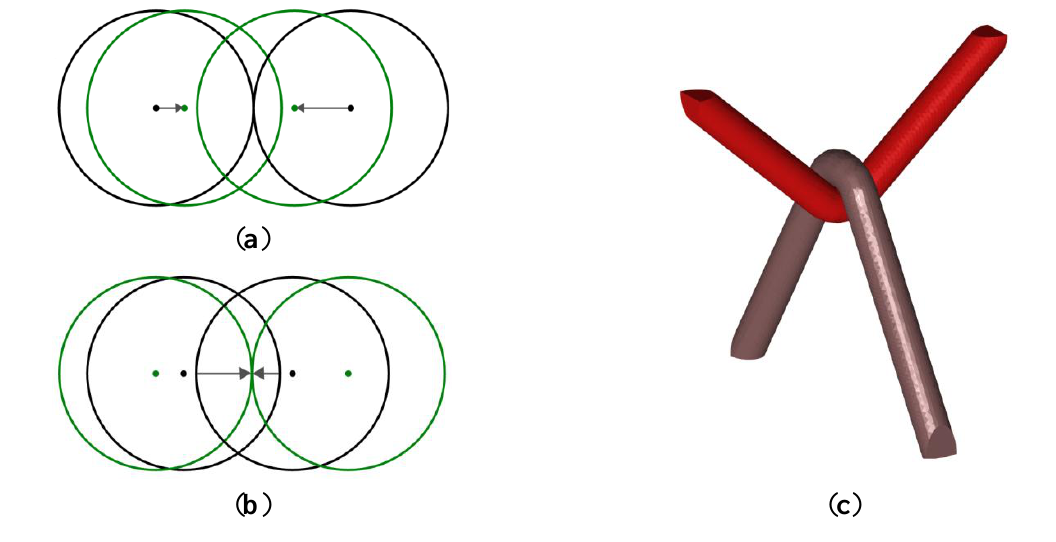
Figure 3. ( a , b ) Schematic representation of operation (A) and (B) respectively, with one yarn twice as much affected by operation (B) as the other, the situation is stationary since operation (A) also produces displacements two time larger for this yarn; and ( c ) corresponding configuration obtained for two yarns of the same initial